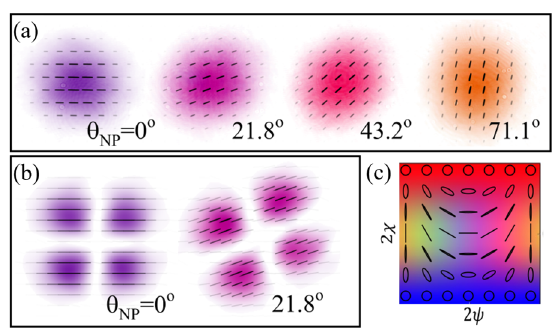
Figure 4: Polarisation rotation: (a) experimental observation of polarisation rotation of a horizontally polarised Gaussian beam (left), for different non-planar geometries (b) polarisation profile of a homogeneously polarised mode before and after rotation. The colour scheme used here HG 1 , 1 and in Figure 5 to map polarisation ellipticity 𝜒 and orientation 𝜓 is shown in (c), while intensity is represented as